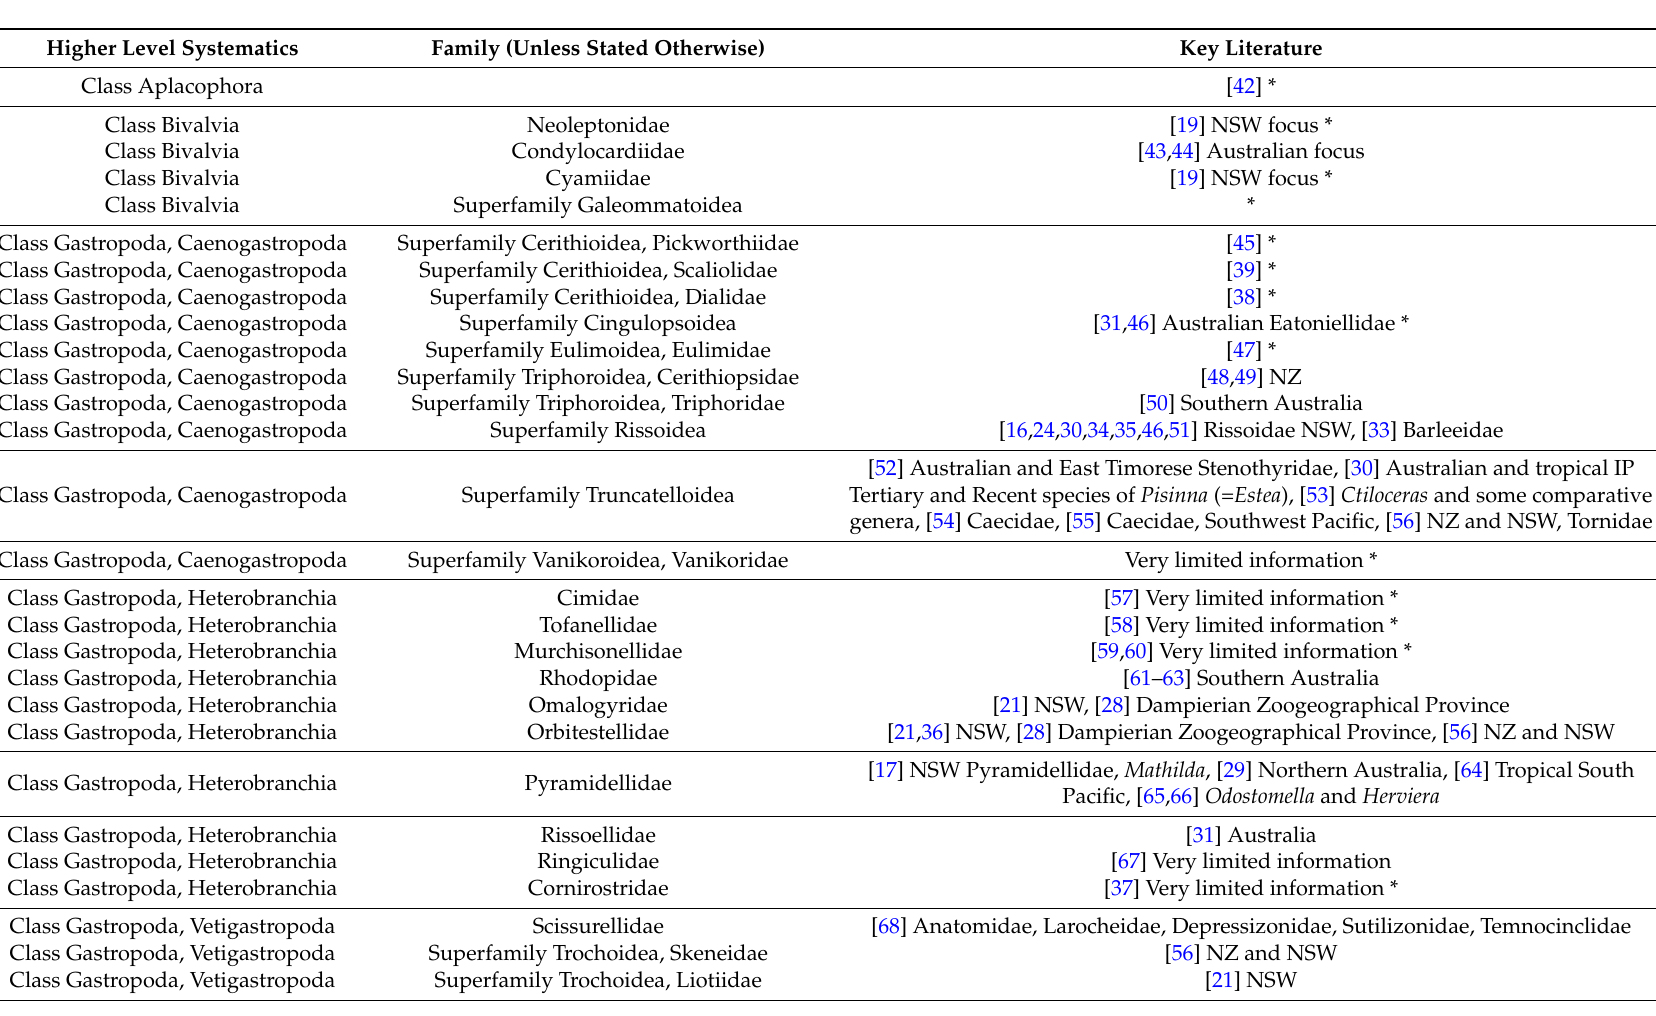
Table 1. Some micromolluscan groups with documented representatives in tropical coral reef environments. * = no recent revision in tropical coral reefs; NZ = New Zealand; NSW = New South Wales; IP = Indo